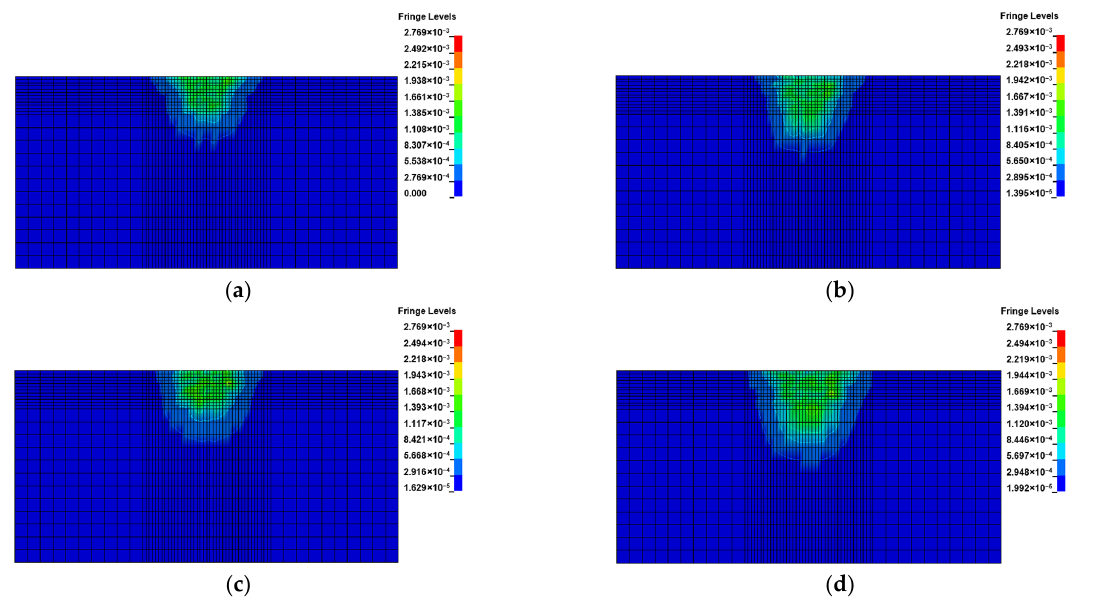
Figure 21. Stress contour of rock breaking using disc cutter with 5 mm blade fillet. ( a ) Stress contour of rock breaking (Blade width 19 mm); ( b ) Stress contour of rock breaking (Blade width 22 mm); ( c ) Stress contour of rock breaking (Blade width 25 mm); ( d ) Stress contour of rock breaking (Blade width 28 mm).